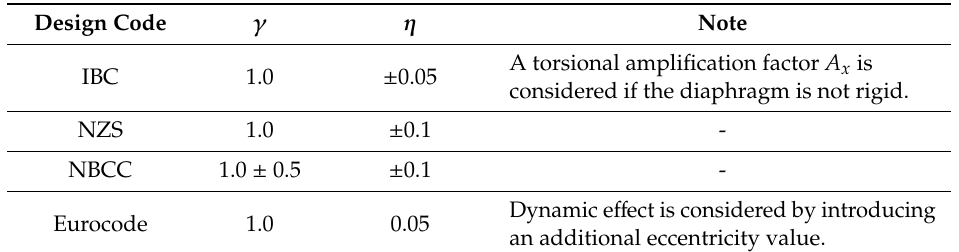
Table 1. Design torsional eccentricity coe ffi cients specified in several current seismic design